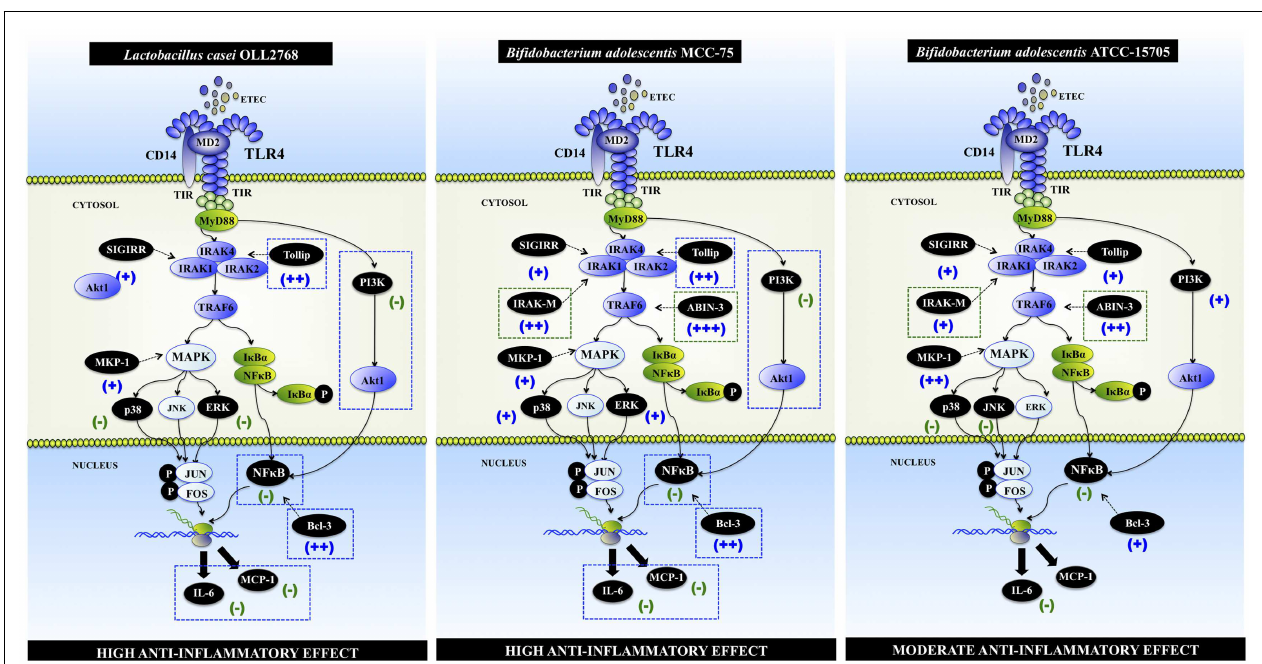
up-regulate the expression ofTLR negative regulators, reduce the activation phosphatidylinositol 3-kinase (PI3K), mitogen-activated protein kinase (MAPK), and nuclear factor κ B (NF- κ B) pathways; and diminish the production of inflammatory mediators by BIE